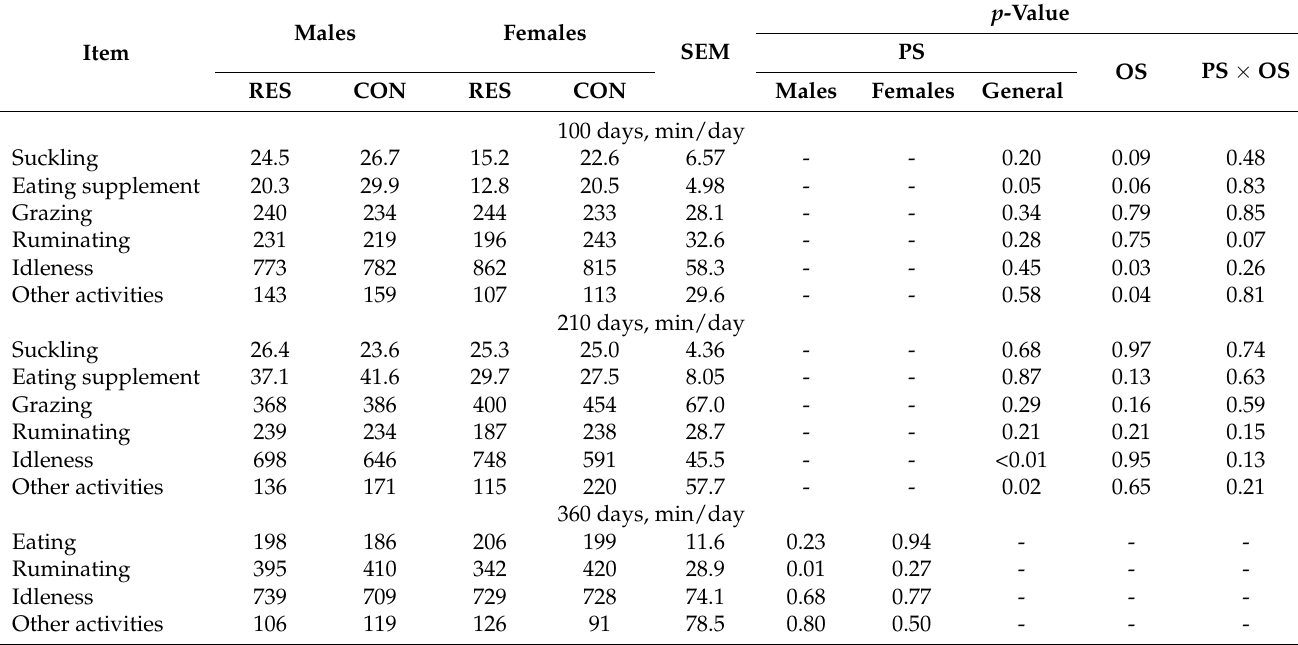
Table 4. Effects of maternal protein supplementation status (PS) and offspring sex (OS) on the calves’ feeding behavior.